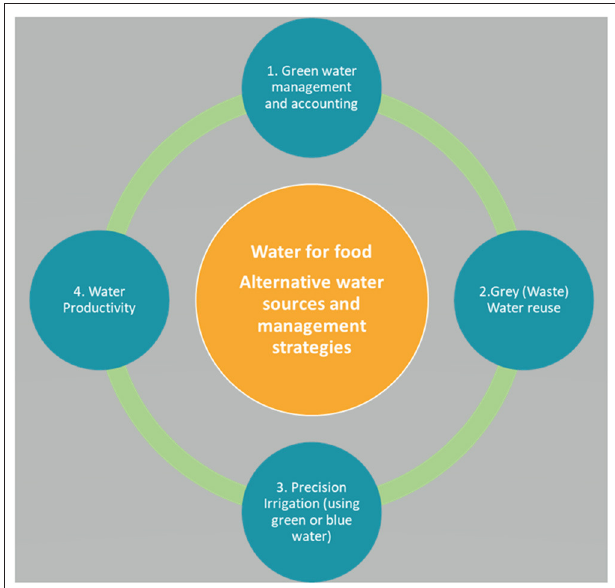
FIGURE 1 | Alternative water management approaches to support food